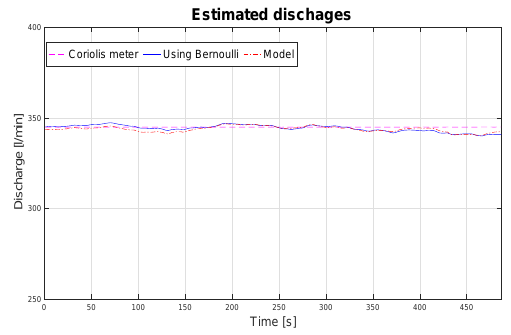
Figure 11: Flow estimation of a single data